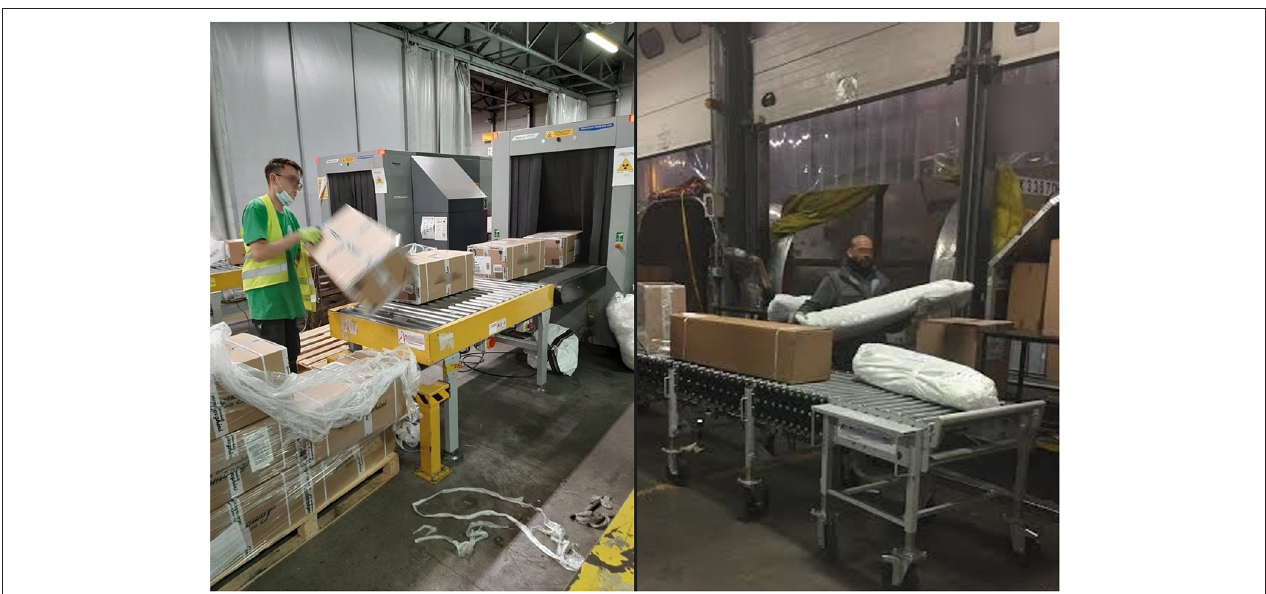
FIGURE 1 | Manual handling of parcels of different weights and dimensions.